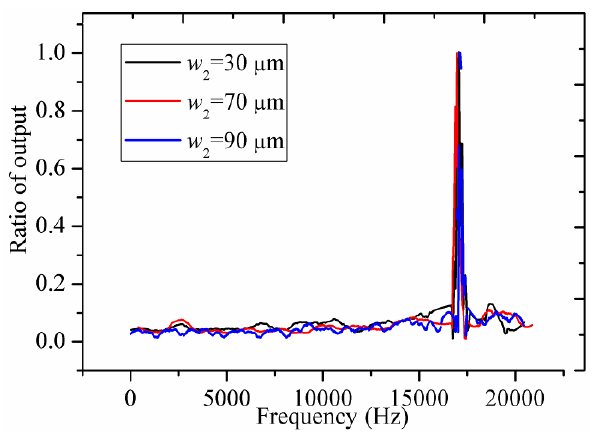
Figure 10. The dynamic curves of output voltage ratios versus different frequencies. Table. 5 The measuring sensitivities and the resonant frequencies.